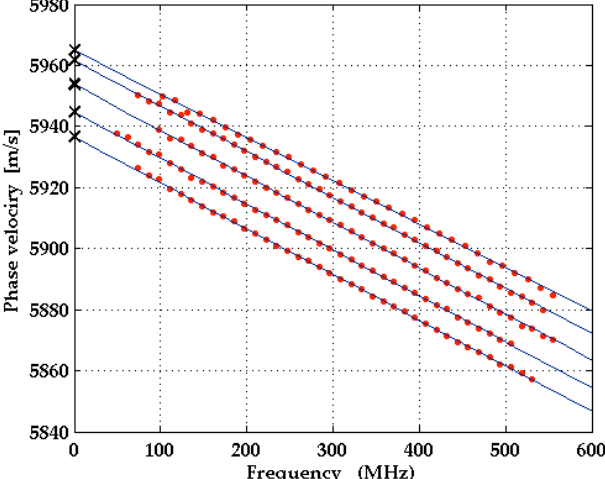
Figure 4. Experimental dispersion curves for the directions θ = 15°, 18°, 21°, 24°, 27° on r-plane sapphire with a 50 nm molybdenum film on top (Sample 2 in Table 2). Extrapolation of fitted straight lines to zero frequency gives the values of phase velocity (black crosses) on pure sapphire.